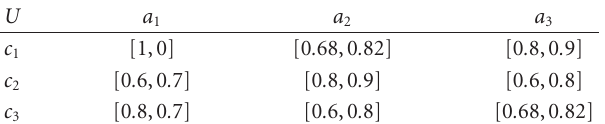
Table 4: Representation of false-membership function of ( (cid:2) F , A ).